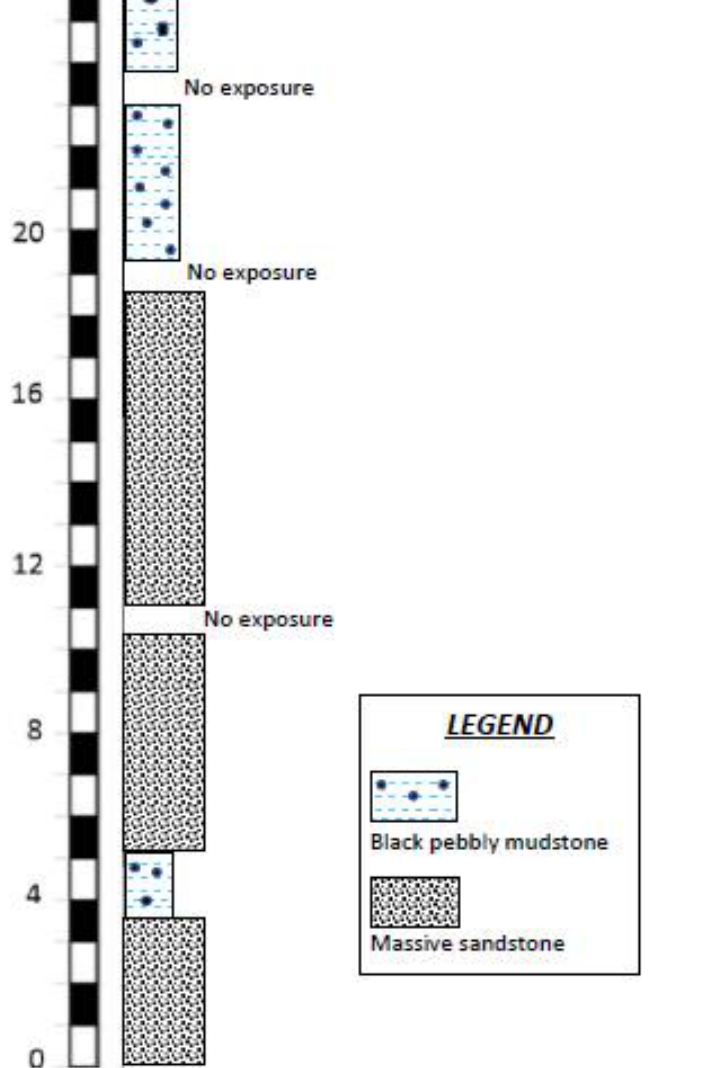
Figure 2. Lithologic log for the Singa Formation section in Langkawi Islands, Malaysia.